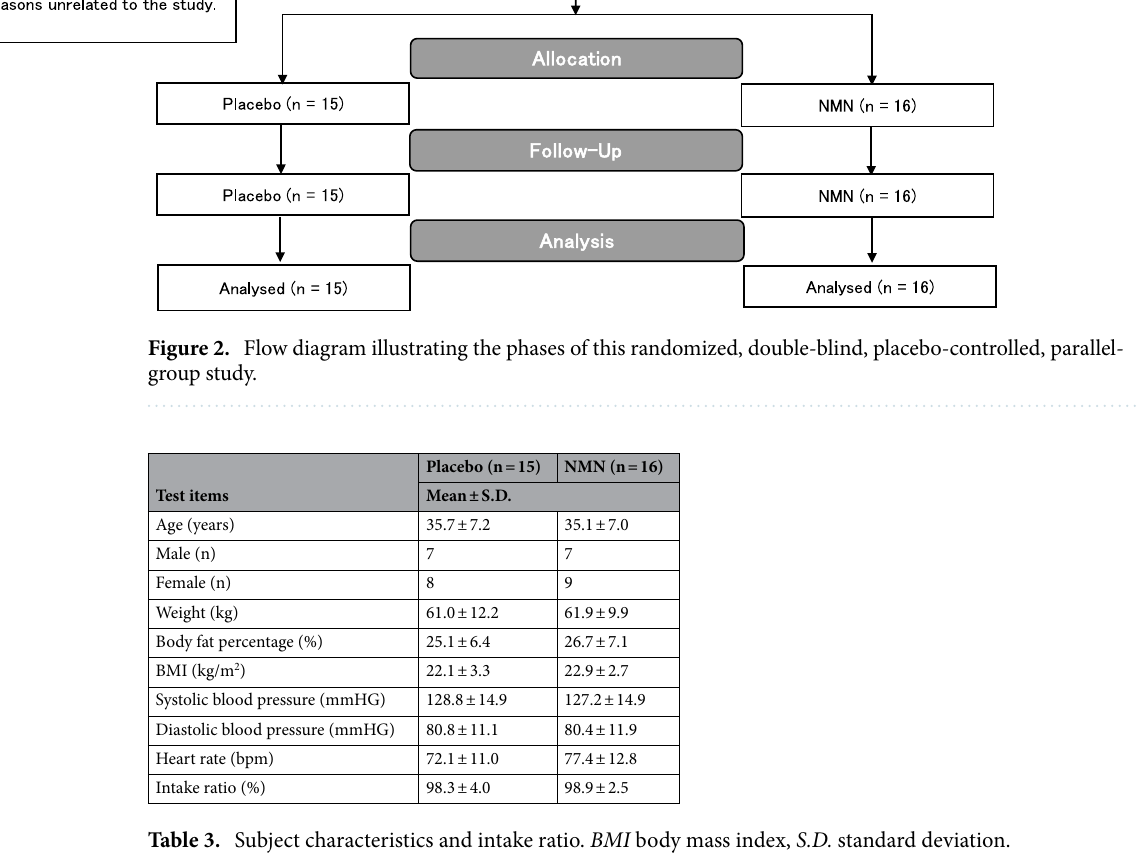
Table S2. All measurements in the NMN and Placebo groups were within the clinical laboratory reference values, and there were no significant differences within or between groups.